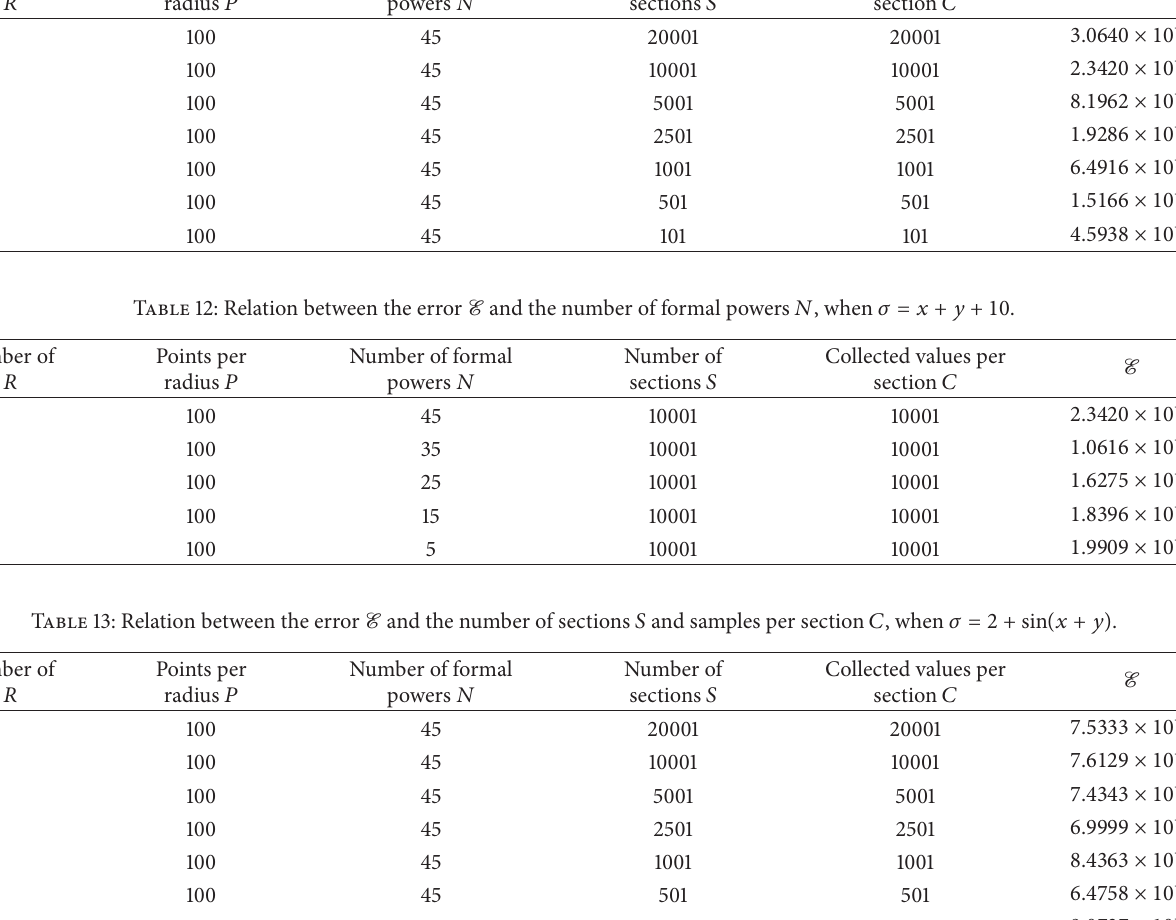
Table 11: Relation between the error E and the number of sections 𝑆 and samples per section 𝐶 , when 𝜎 = 𝑥 + 𝑦 + 10 . Number of